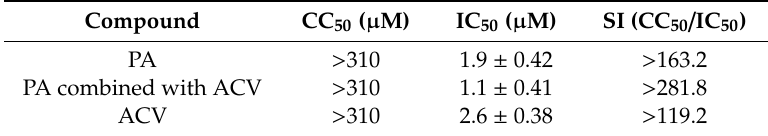
Table 1. Antiviral activity against the replication of herpes simplex virus type 1 (HSV-1) and cytotoxicity properties. Compound CC 50 ( µ M)